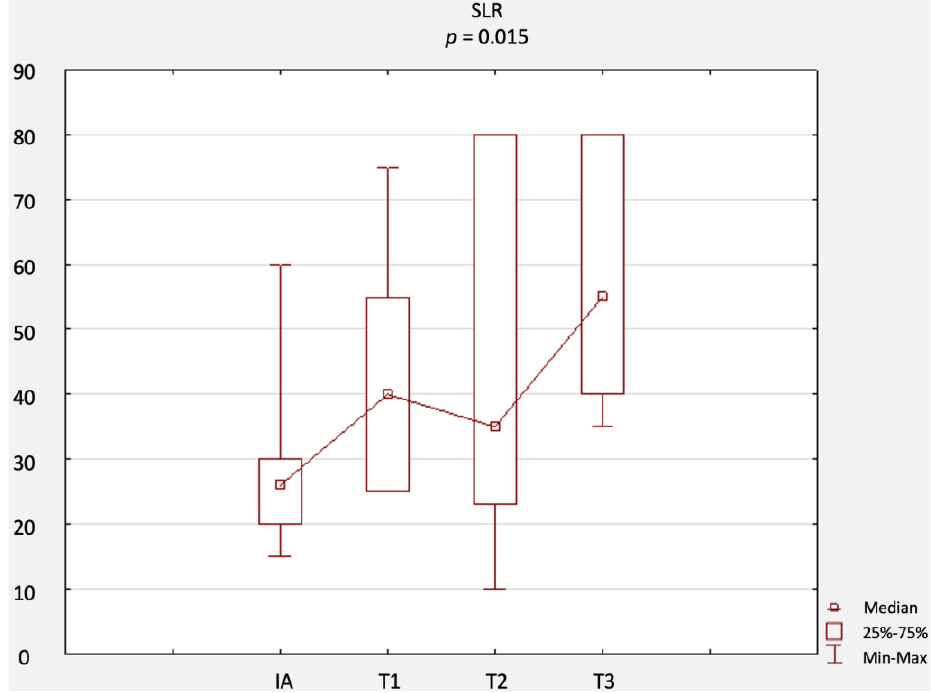
Figure 5. Comparison of SLR results at IA, T1, T2, and T3. Abbreviations: SLR, straight leg raise; IA, initial assessment; T1, first-month assessment; T2, second-month assessment; T3, third-month assessment.